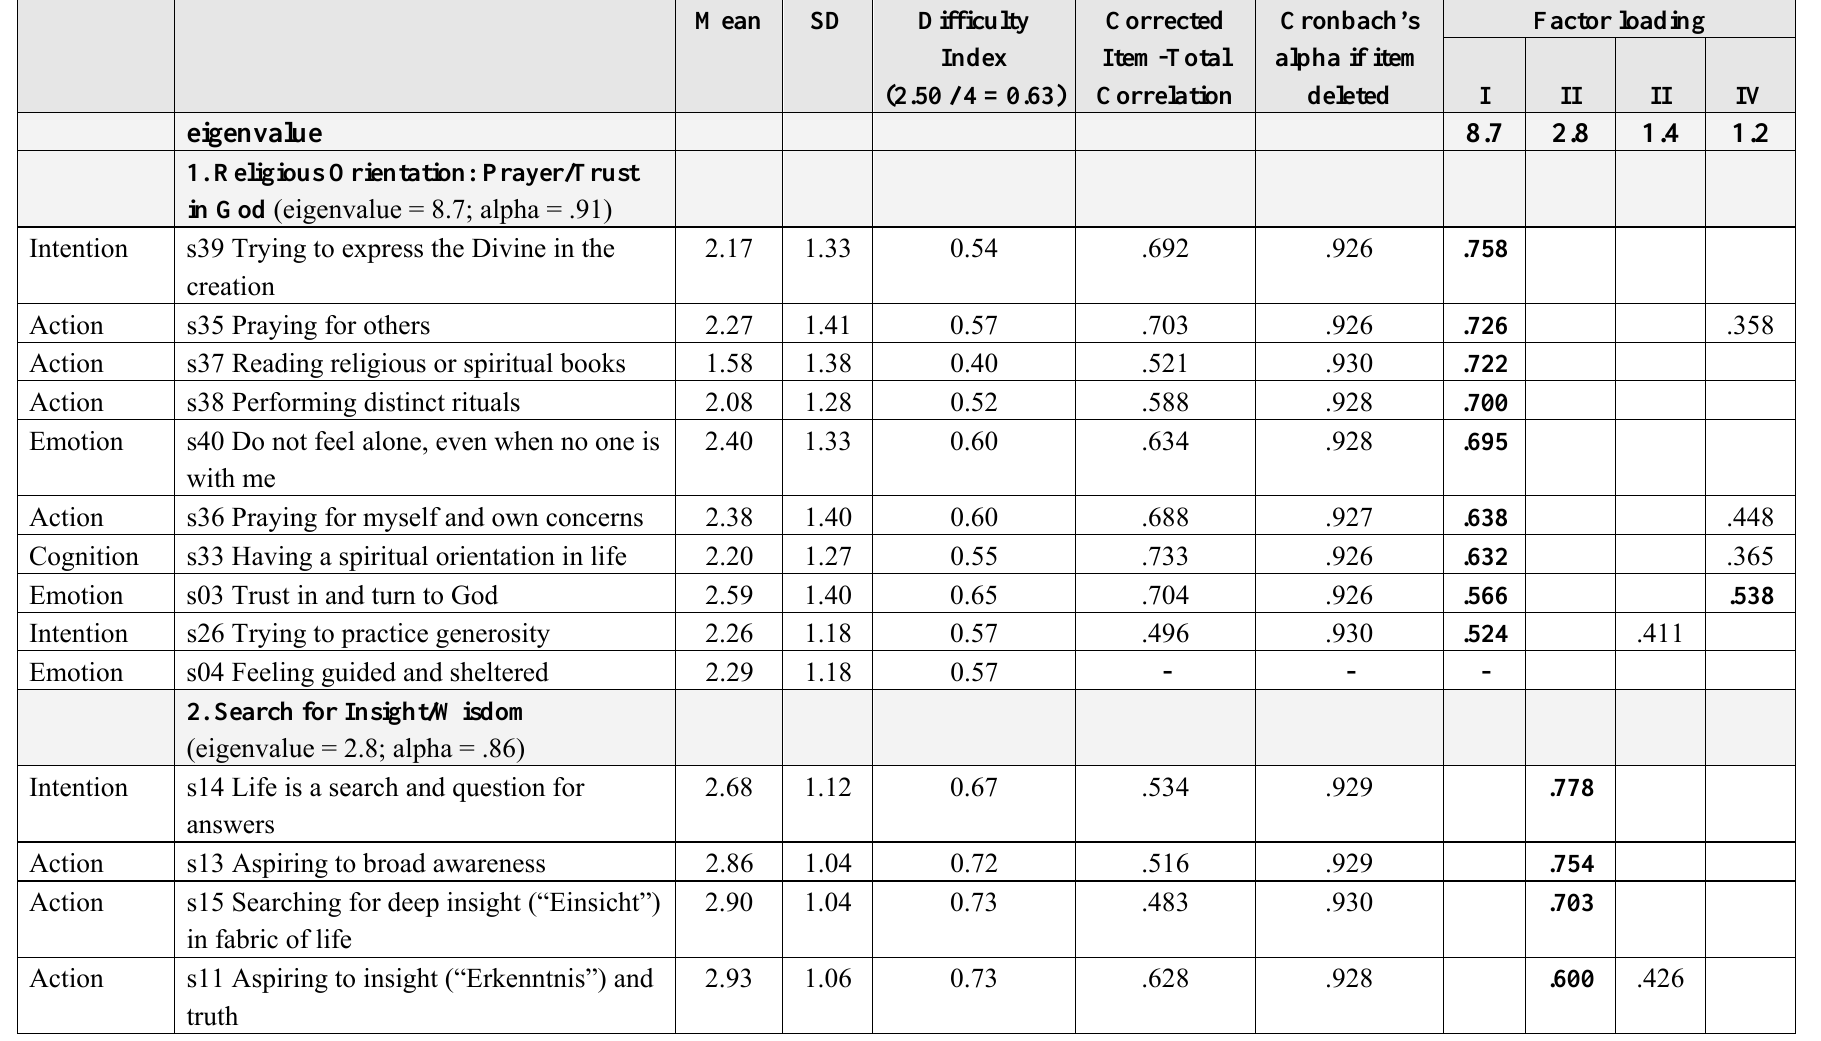
Table 3. Factors of the ASP questionnaire in its Polish version (23 items)—Polish sample. Mean SD Difficulty (2.50 / 4 = 0.63)